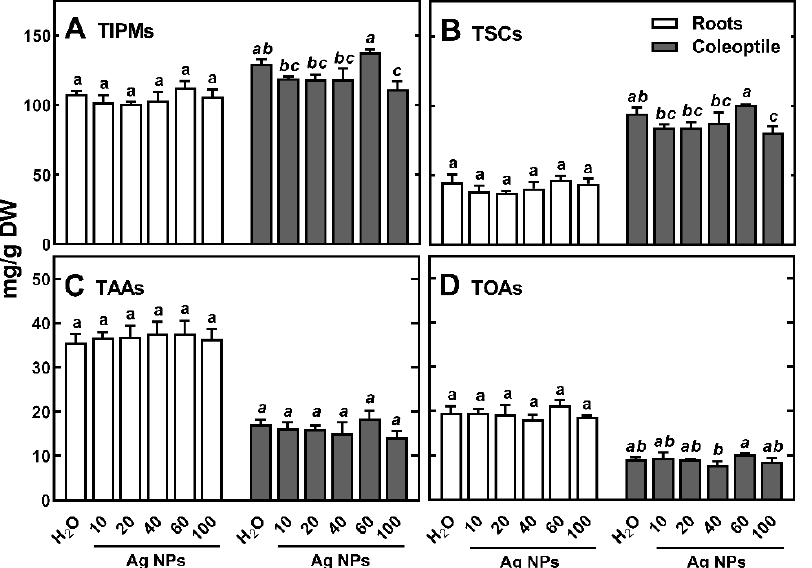
Figure 5. The effect of various sized Ag NPs citrate-stabilized at 20 mg/L on the concentration of total identified polar metabolites (( A ), TIPMs), including total soluble carbohydrates (( B ), TSCs), total amino acids (( C ), TAAs), and total organic acids (( D ), TOAs) in roots and coleoptile of 3-day-old seedlings of wheat ( Triticum aestivum L. cv. ‘Ostka Strzelecka’). Control grains were germinated in double distilled water. Values are means ( n = 3) + SD. Bars with the same letters (a–b, a–c ) are not significantly ( p < 0.05) different after the ANOVA test and Tukey’s post hoc